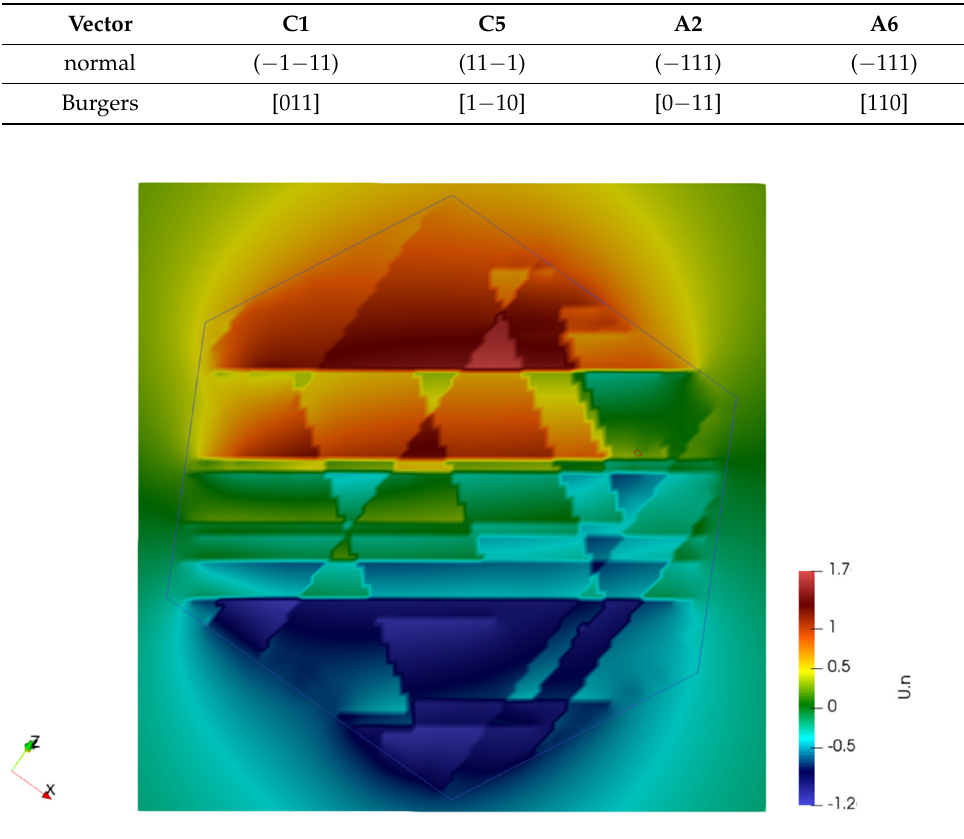
Figure 4. Typical plastic steps printed on the 5 µm × 5 µm probing plane defined in Figure 3 after 10 − 4 cumulated plastic tensile strain obtained by a DDD simulation. Scale is in nanometers. Colors correspond to the projection of the dislocation displacement field along the plane normal [0 −